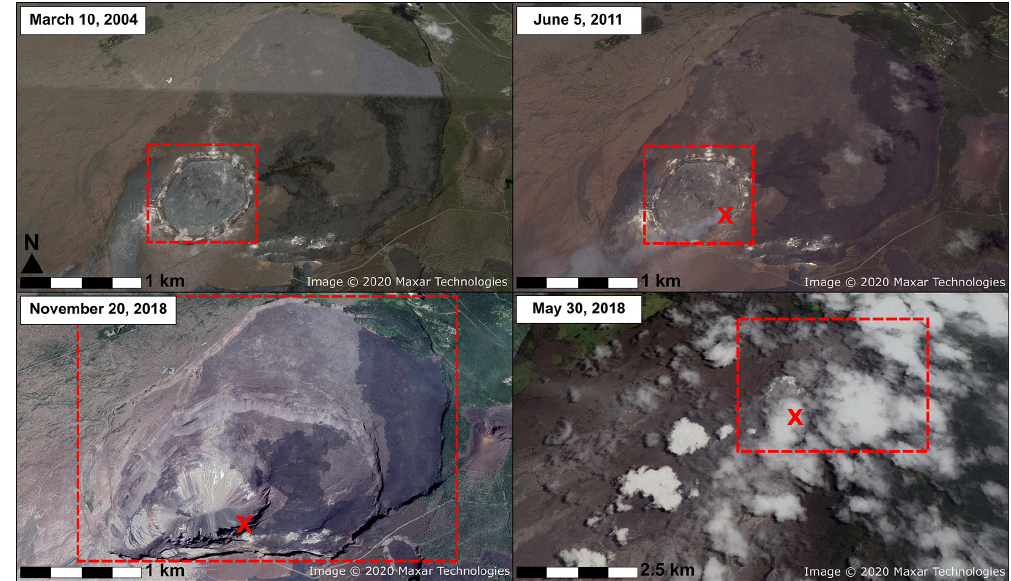
Figure 1. © Google Earth imagery of the Kilauea summit crater before and after each degassing event. Clockwise from top left: pre-2008 degassing, post-2008 degassing, during 2018 peak degassing, and post-2018 degassing. The image from 5 June 2011 shows the summit vent, which was not present prior to the 2008 event, passively degassing during an eruptive lull. The image from 30 May 2018 was taken on a cloudy day during the 2018 event, several days after peak observed SO 2 emissions ( > 100ktd − 1 ) and plume height ( < 8km) (Kern et al., 2020). The red boxes approximately outline the summit crater, while the X symbols indicate the degassing